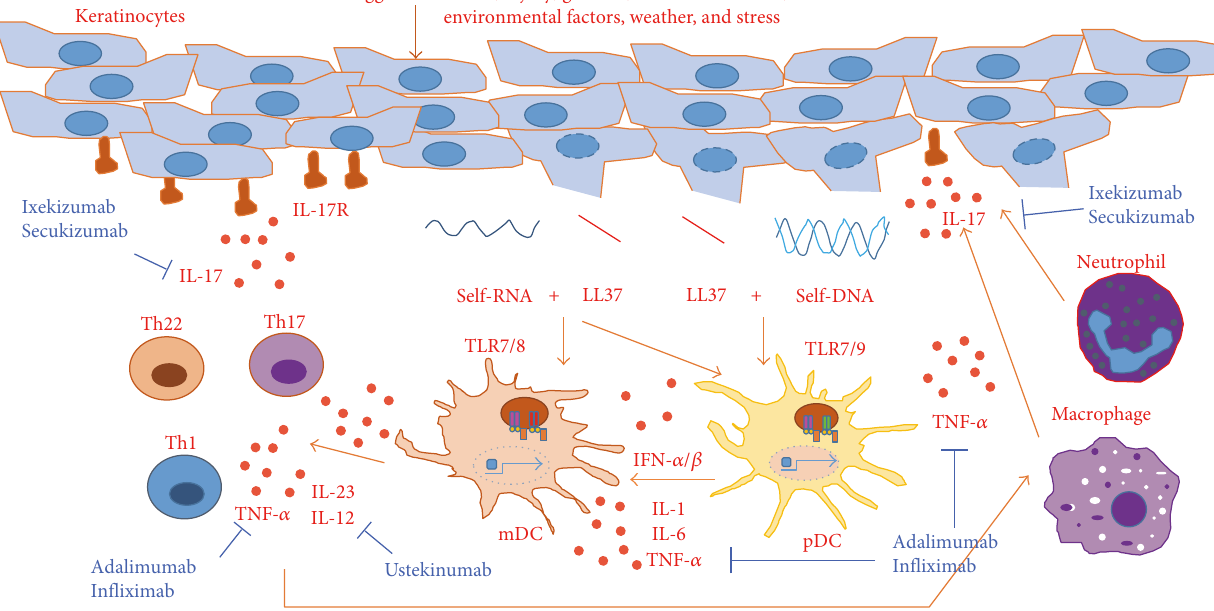
Figure 3: The role of endosomal TLRs in the development of psoriasis and the mechanism of action of biological drugs. Endosomal TLRs in plasmacytoid dendritic cells (pDCs) and myeloid dendritic cells (mDCs) can be triggered by self-DNA and self-RNA that forms complexes with LL37 upon its release from necrotic cells. Cytokines released by DCs further drive T cell-mediated in fl ammation by activating cytokines that promote leukocyte recruitment and keratinocyte activation and proliferation. Blue font: biological drugs inhibit e ff ector cytokines in psoriatic in fl